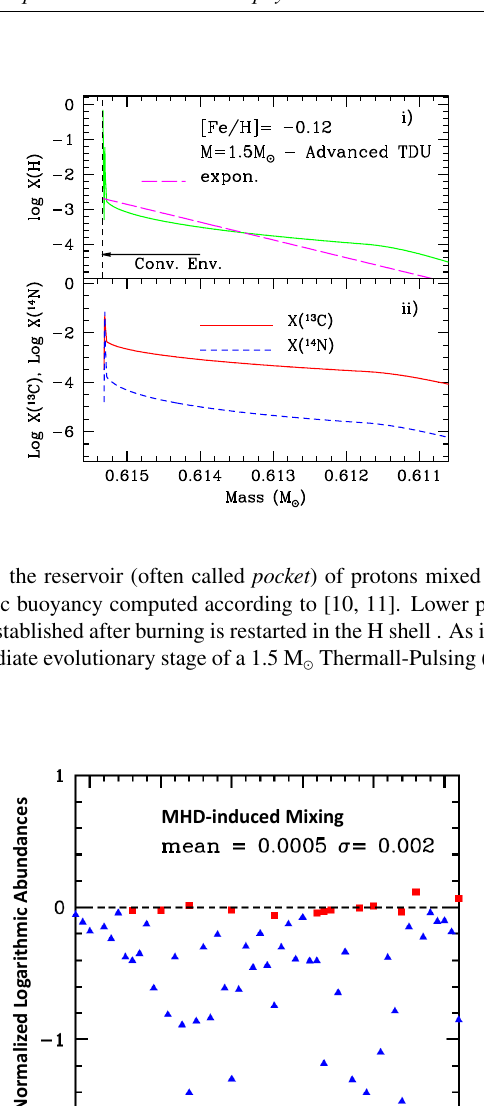
This is shown in Figures 2 and